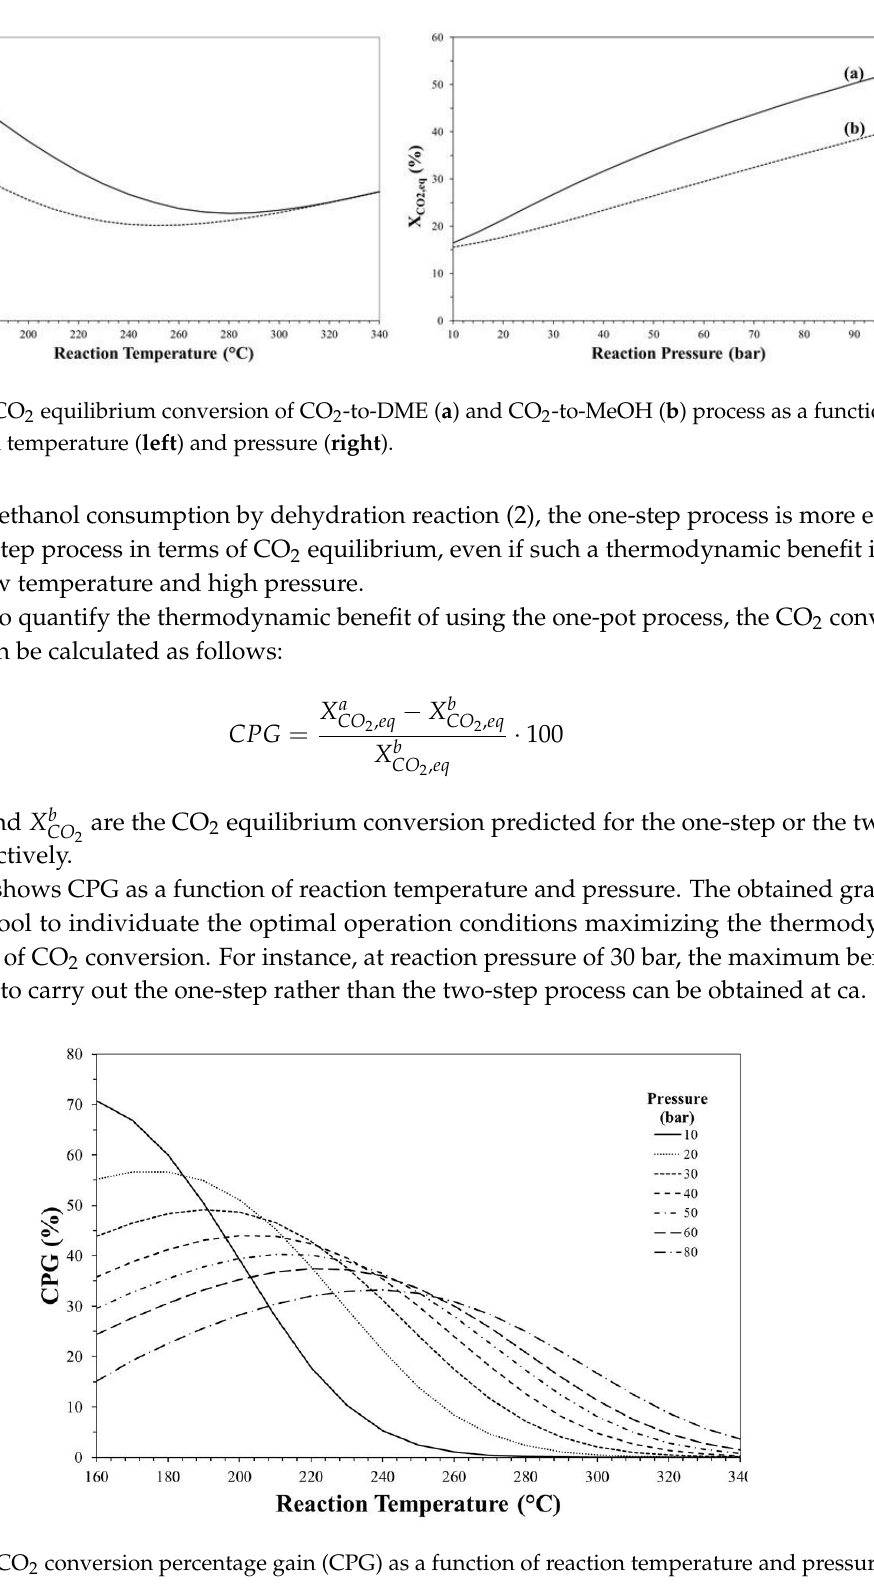
Figure 8. CO 2 conversion percentage gain (CPG) as a function of reaction temperature and pressure.